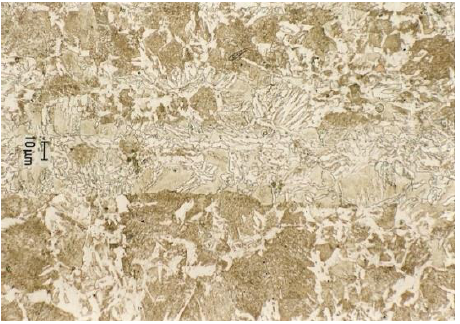
Figure 16. Detail of a martensitic structure passing through the center of the sheet.